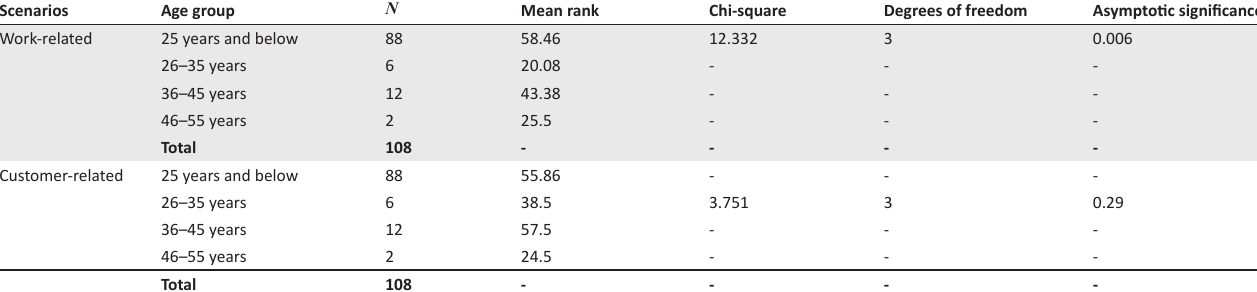
TABLE 2: Results of the Kruskal–Wallis rank sum test with age as the grouping variable. Scenarios Age group Mean rank Chi-square Degrees of freedom Asymptotic significance